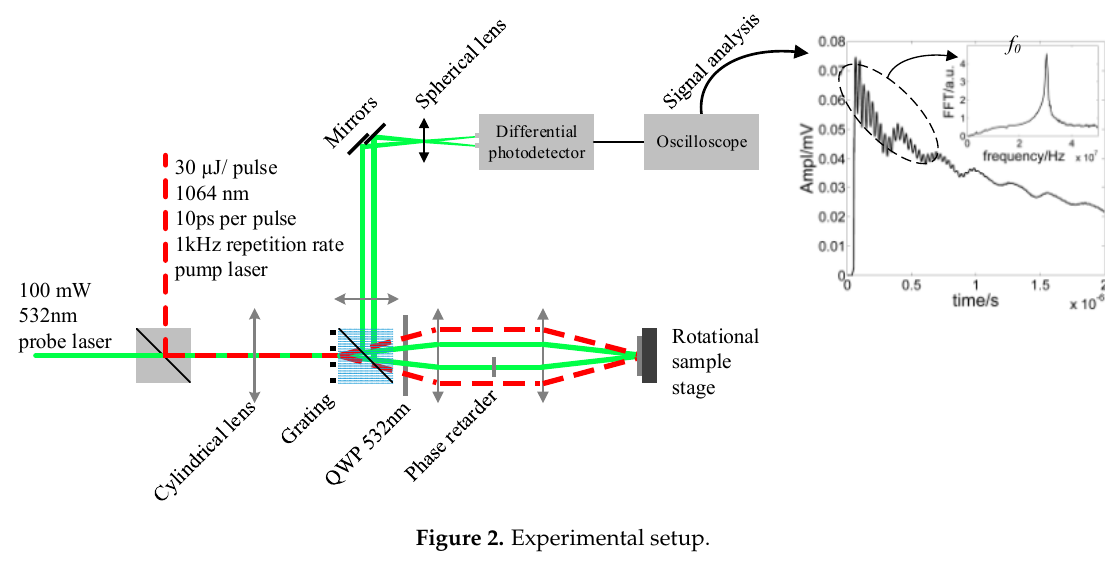
Figure 2. Experimental setup.